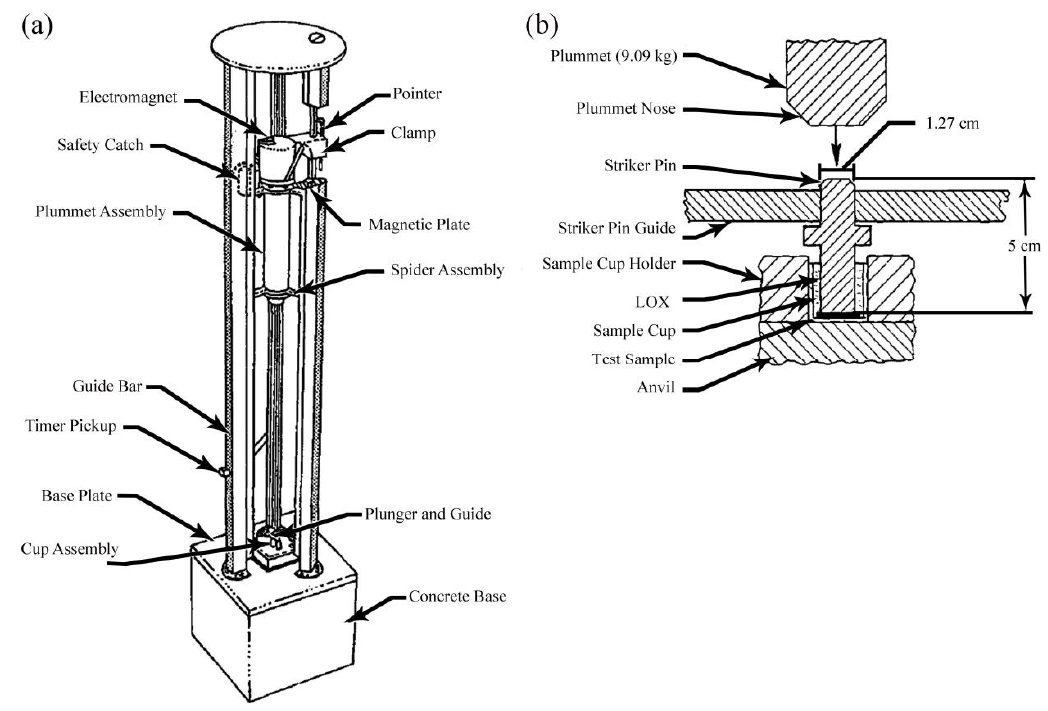
Figure 1. ( a ) Diagram of the ambient pressure liquid oxygen mechanical impact test facility. ( b ) The striker pin assembly detail, reproduced from [41] with permission from ASTM, 2019.